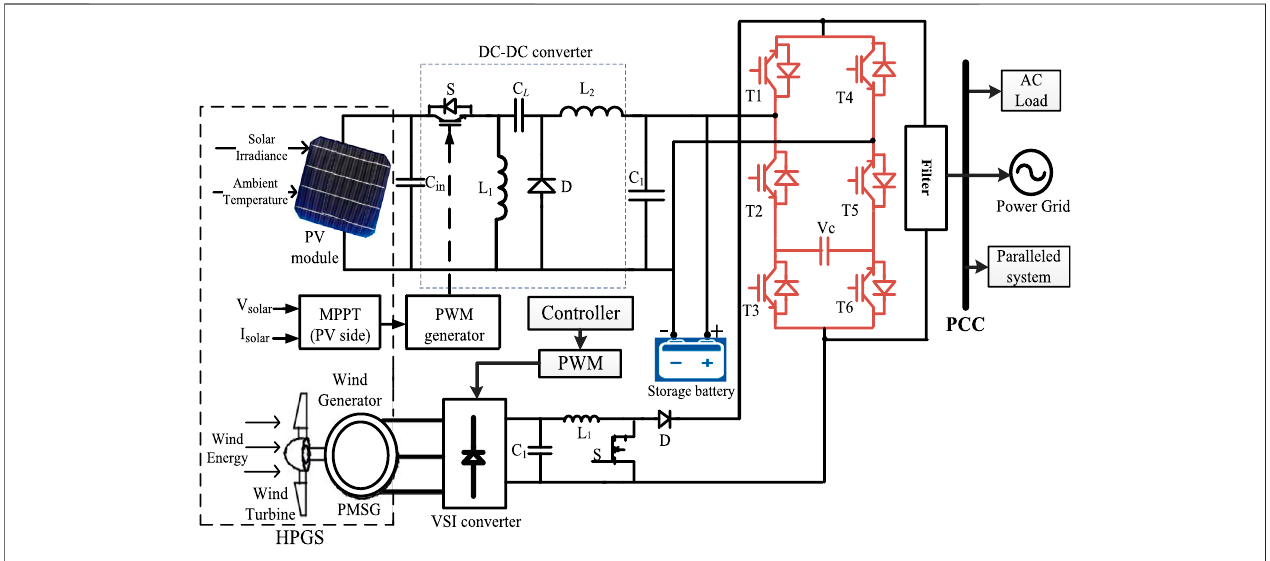
FIGURE 1 | Schematic block illustration of the grid-connected HPGS through inverter ’ s topology.